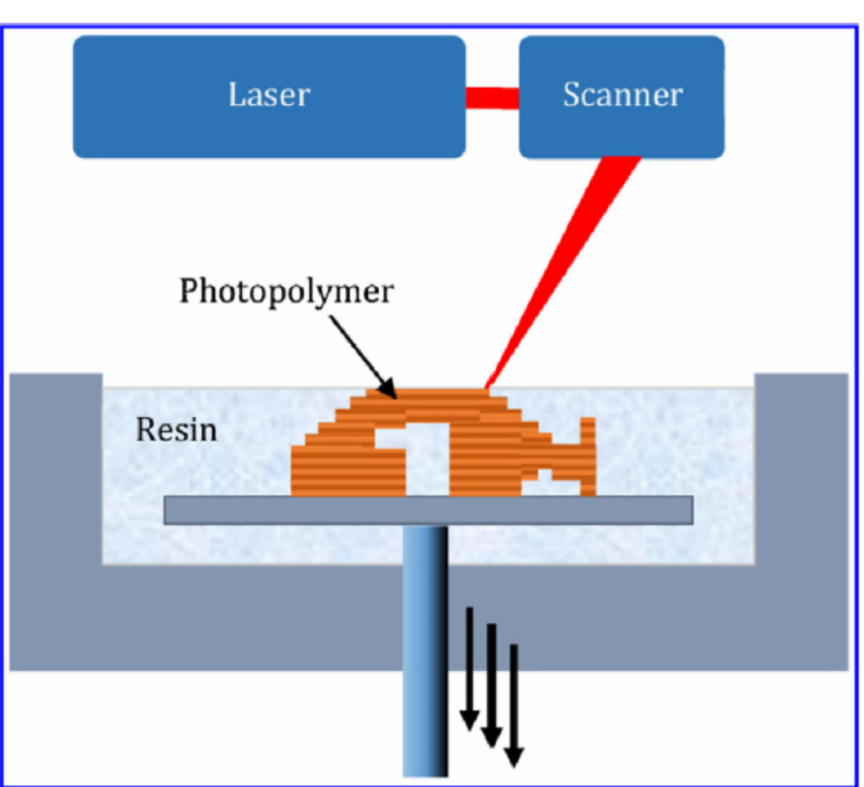
Figure 2. Illustrative scheme to introduce the configuration of stereolithography. Copyright 2016 John Wiley@Sons. Reprinted with permission from ref.